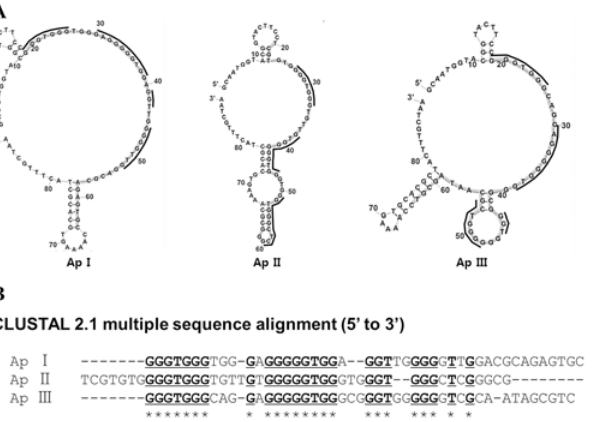
Fig 5. Predicted structures and sequence alignments of selected aptamers. (A) Mfold-predicted secondary structures of selected aptamers with shaded nucleotides representing the 45-nucleotide random sequence region. (B) Conserved sequences identified by ClustalW2 indicated by asterisks and underlines, and shown in (A) as solid